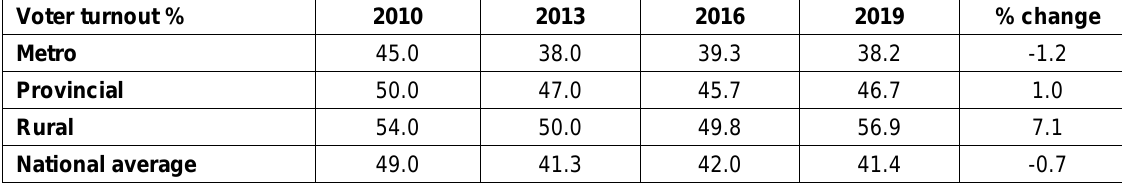
Table 3: Voter turnout by metropolitan, provincial and rural local authorities Voter turnout %